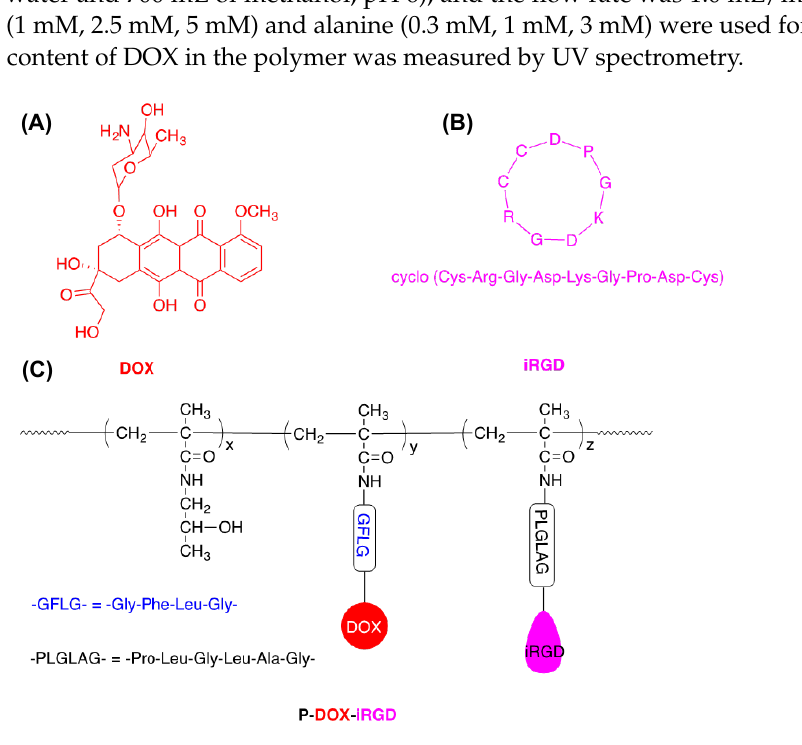
Figure 1. Chemical structures of ( A ) DOX, ( B ) RGD, and ( C ) P-DOX-iRGD.